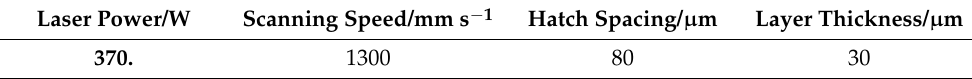
Table 1. Processing parameter of samples.